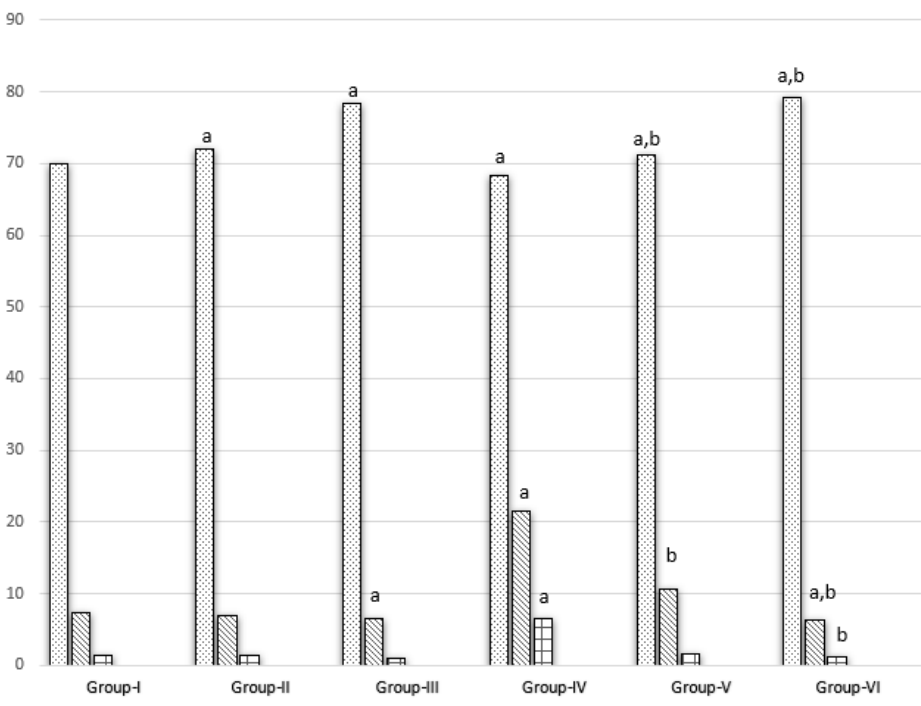
Figure 3. DMH, CUR, and CUR-loaded PLGA effect on cell cycle progression in various groups. a represents statically significant differences at ( p < 0.05), compared different groups with Group-I and b represents statically significant differences at ( p < 0.05), compared different groups with Group-IV.